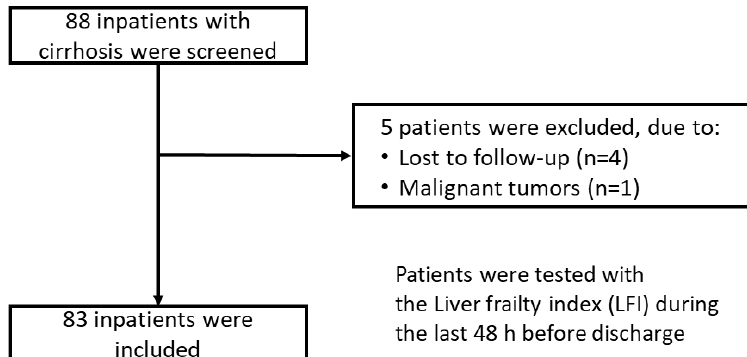
Figure 1. Consort flow chart of the study.